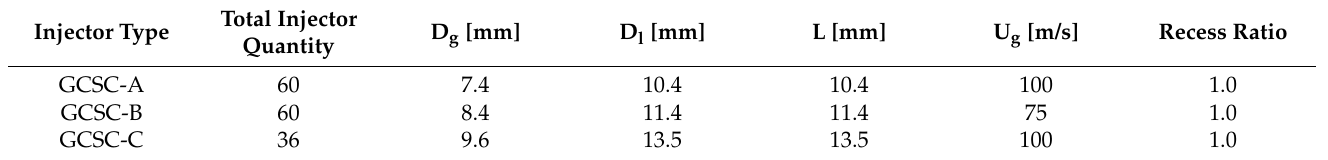
Table 1. Injector configuration.